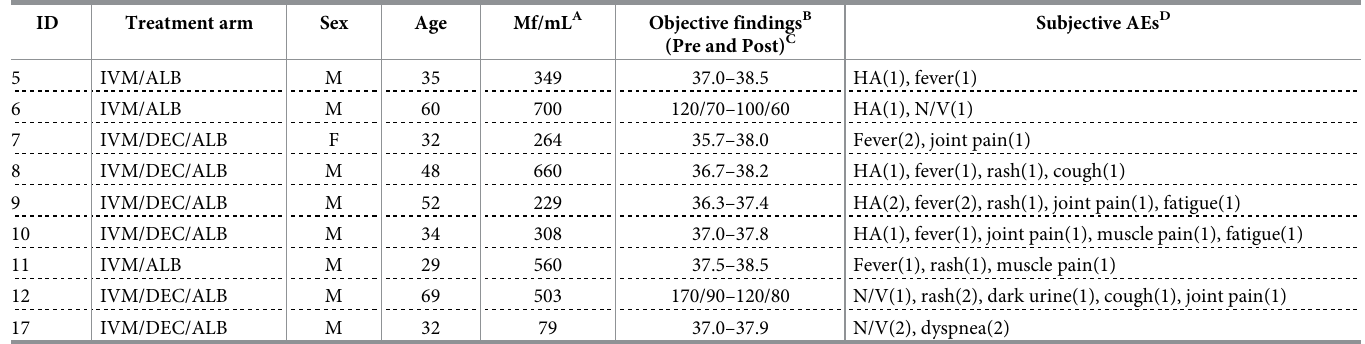
Table 1. Clinical characteristics of the nine individuals with moderate adverse events (AEs) after LF